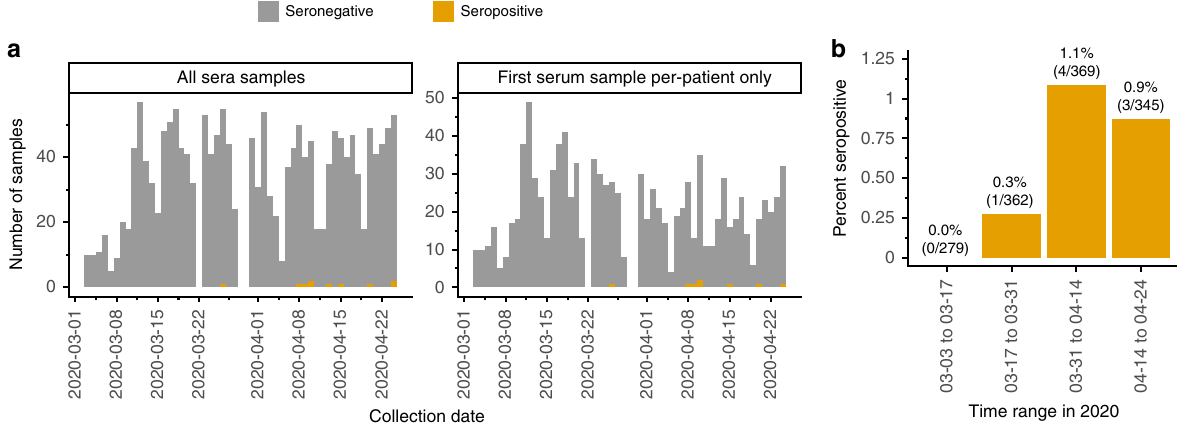
Fig. 2 Frequency of seropositive samples over time. a Total and seropositive samples collected each day, with stacked bars showing seropositive samples in orange and seronegative ones in gray. The left panel shows all samples, while the right panel shows only the fi rst sample from each patient. b Percentage of tested patients with at least one seropositive sample during each 2-week period.